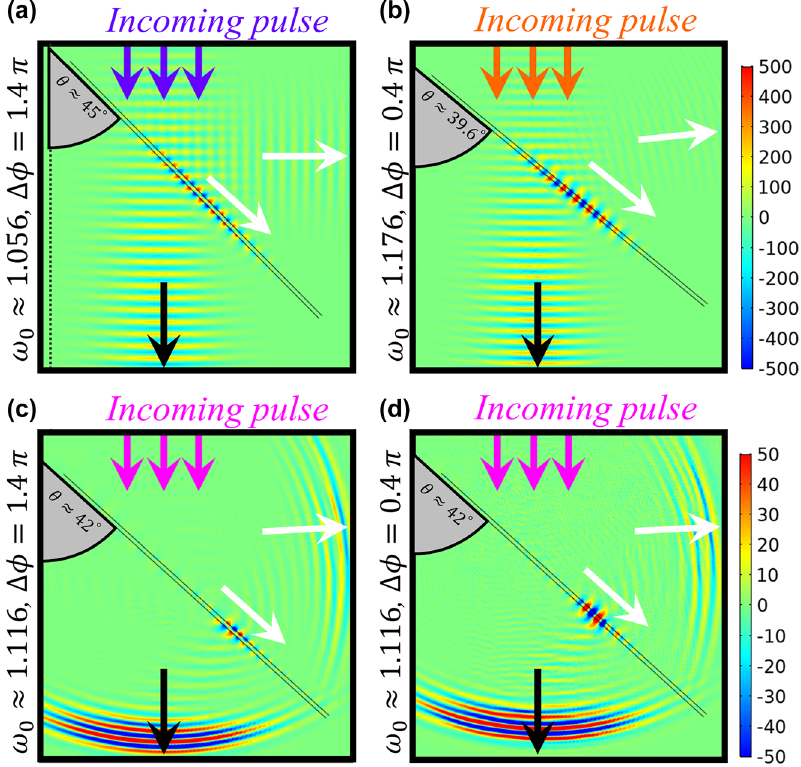
Figure 4: The snapshots of surface excitations at t ≈ 186. Temporal simulations of phased dynamical wood anomalies predicted in Figure 3a and b on-resonance pulses with carrier frequencies ̃𝜔 ≈ 1 . 056 (purple arrows) and ̃𝜔 ≈ 1 . 176 (orange arrows) impinge on the DFS ( 𝛼 = 0 . 15) with phase differences (a) Δ 𝜙 ≈ 1.4 𝜋 and (b) 0 , − 0 , + Δ 𝜙 ≈ 0.4 𝜋 , individually optimized to excite anti-symmetric and symmetric SWs in the respective cases with high efficiency. (c, d) an ≈ 1 . 116 (pink arrows) impinges on the time-phased DFS ( 𝛼 = 0 . 15) with Δ 𝜙 ≈ 1.4 𝜋 and off-resonant pulse with carrier frequency ̃𝜔 c Δ 𝜙 ≈ 0.4 𝜋 , efficiently exciting SWs of either symmetry based uniquely on the modulation phase Δ 𝜙